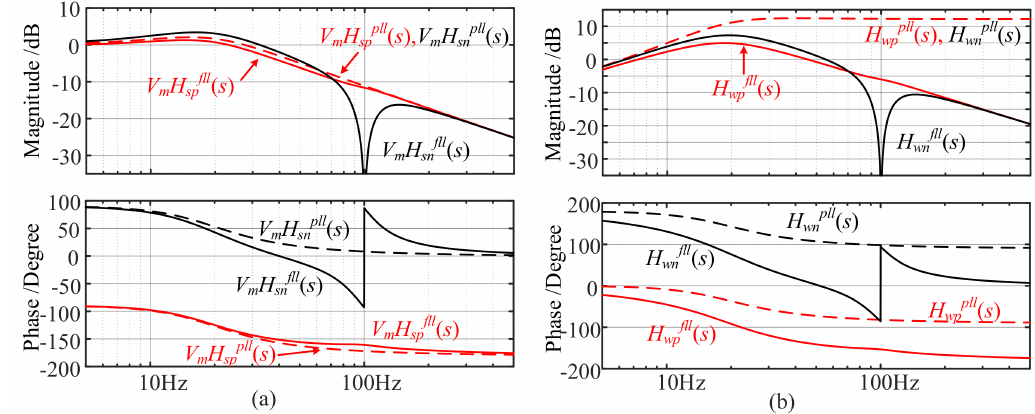
Figure 10. Frequency response of the effects of point of common coupling (PCC) voltages on θ f in